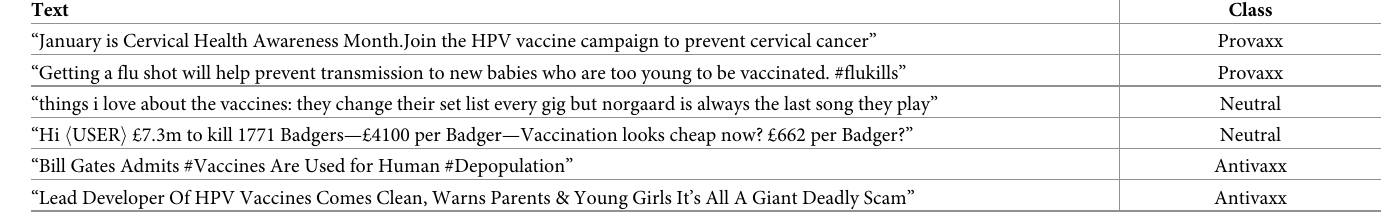
Table 1. Qualitative summary of classifier performance. The classifier correctly assigns a large probability of antivaxxness to text snippets the express conspiracist notions about vaccines being part of a global scam. Similarly, texts highlighting the positive qualities of vaccinations are assigned a high probability of being provaxx. In addition, text snippets concerning the band named The Vaccines are recognized as irrelevant. A text snippet expressing how much more expensive it is to kill, rather than vaccinate, badgers is also categorized as irrelevant with a high certainty, despite containing negative words like ‘kill’. Text “January is Cervical Health Awareness Month.Join the HPV vaccine campaign to prevent cervical